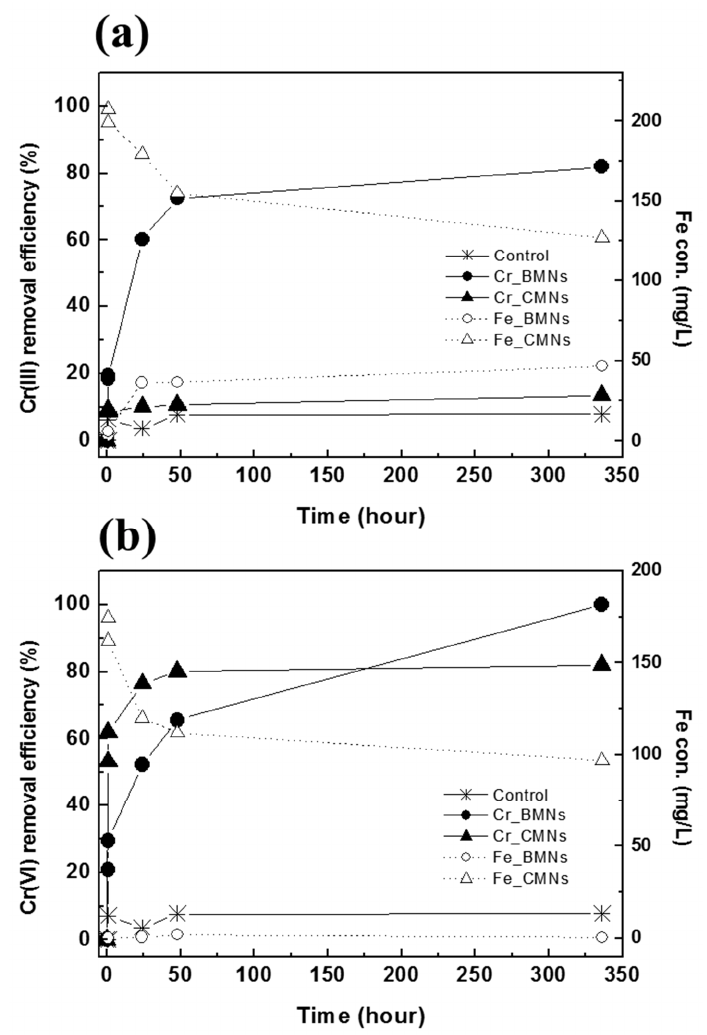
Figure 2. Cr removal efficiencies and Fe concentrations during two weeks in ( a ) Cr(III) and ( b ) Cr(VI) by BMNs and CMNs.